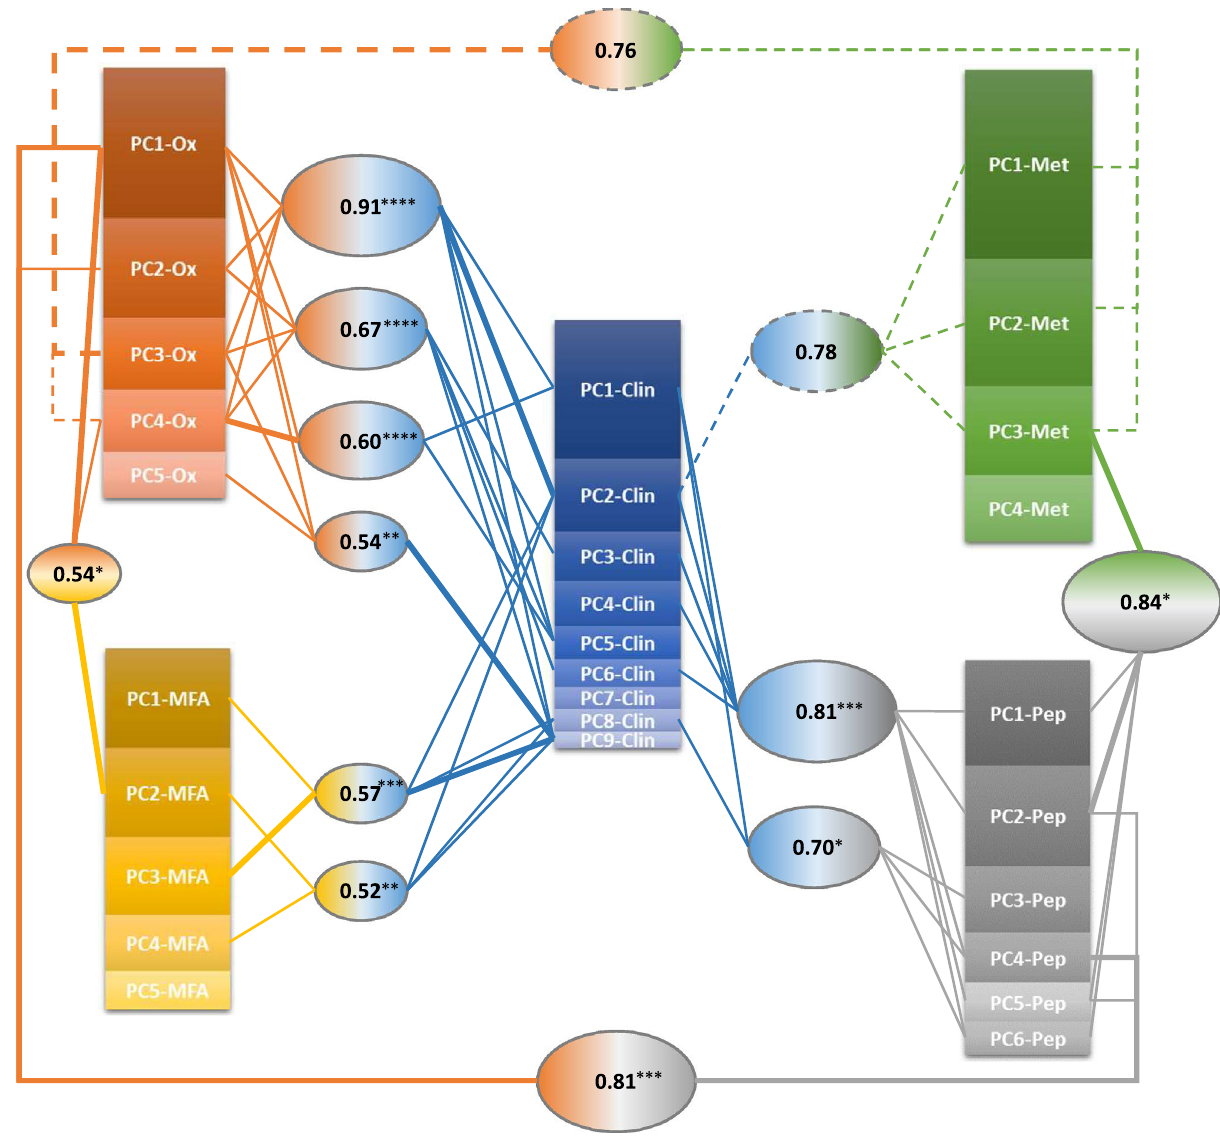
Figure 4. Graphical representation of the canonical correlation analysis. Each oval box represents a significant correlation (r) between linear combinations of PCs from two data set, with lines indicating the PCs from each data set significantly contributing to the combination. Thick lines indicate prominent contributions, i.e. the PC with a coefficient at least 1.5 times greater in modulus than that of any other PC in the same combination. PC box size is proportional to the variance explained by that PC within the dataset. ****p < 0.0001; ***0.0001 ≤ p < 0.001; **0.001 ≤ p < 0.01; *0.01 ≤ p < 0.05. Dashed lines indicate not statistically significant (0.05 < p < 0.15) though very strong (r > 0.7)